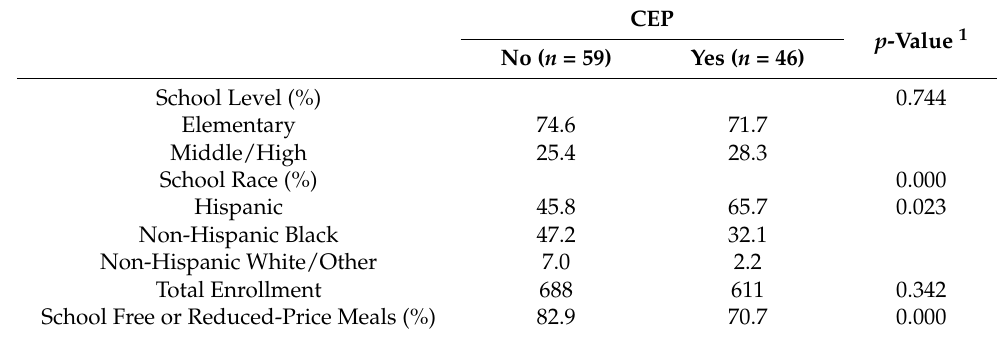
Table 1. Descriptive characteristics of the schools included in the analysis by CEP status ( n = 105).